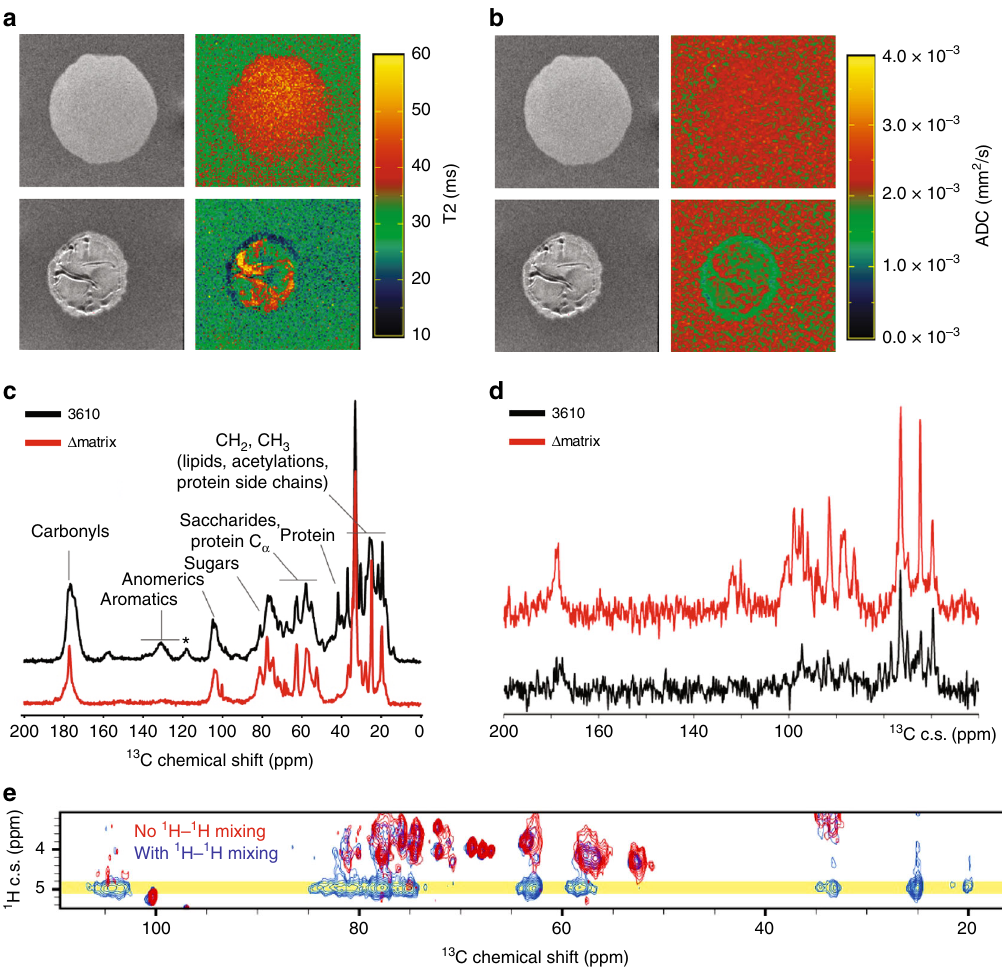
Fig. 4 The B. subtilis extracellular matrix functions as a physical barrier. a , b Magnetic resonance imaging (MRI) analysis of Δ matrix and 3610 colonies after 72 h of growth on LB media. c – e Characterization by solid-state NMR of 3610 and Δ matrix grown on LB media after 72 h. a Transversal relaxation times (T 2 ) of Δ matrix and 3610 colonies. T 2 -weighted (gray scale images) and T 2 map (heatmap) of Δ matrix and 3610 colonies. b Apparent diffusion coef fi cient (ADC) of Δ matrix and 3610 colonies. c 13 C cross-polarization spectra of 13 C-labeled 3610 and Δ matrix samples. d 13 C-detected spectra of the 3610 and the Δ matrix samples after a T2- fi lter and a 1H spin diffusion of 5 ms. e Superimposition of 2D 1 H- 13 C HETCOR experiments of Δ matrix recorded without (in red) and with (in blue) a 1H spin diffusion mixing time. The bulk water frequency is indicated in